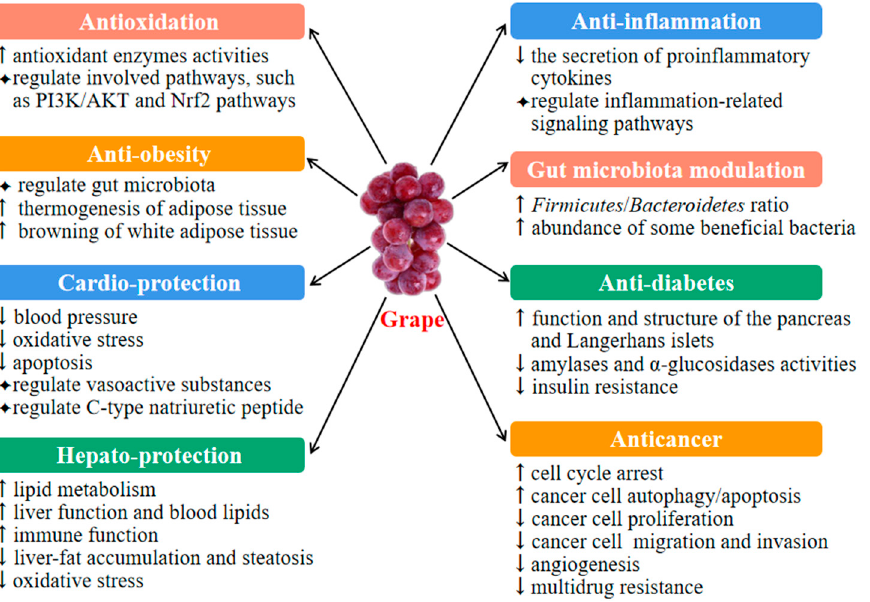
Figure 2. The health benefits of grape. Grape showed several bioactivities with different mechanisms of action. The up arrow ↑ represents increase, down arrow ↓ represents decrease, and the ◆ represents regulate.